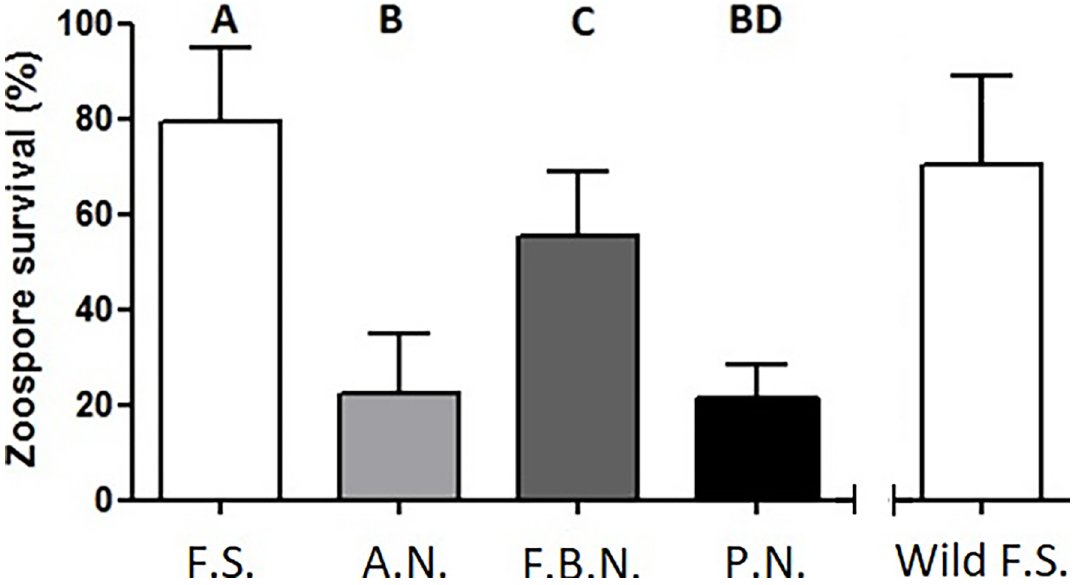
Fig 2. Bsal zoospore survival after exposure to different species mucosomes. F.S. = fire salamander (n = 8), A.N. = alpine newt (n = 8), F.B.N. = Japanese fire belly newt (n = 6), P.N. = palmate newt (n = 6). Wild F.S. are depicted for comparison but originated from a separate experiment (n = 15). Shown are the mean +/- SD of the percentage of viable zoospores observed after 60 minutes of incubation (compared with control, viable spores in water). F.S. vs A.N. (p < 0.001), F.S. vs F.B.N. (p = 0.011), F.S. vs P.N. (p < 0.001), A.N. vs F. B. N. (p < 0.001), A.N. vs P. N. (p =